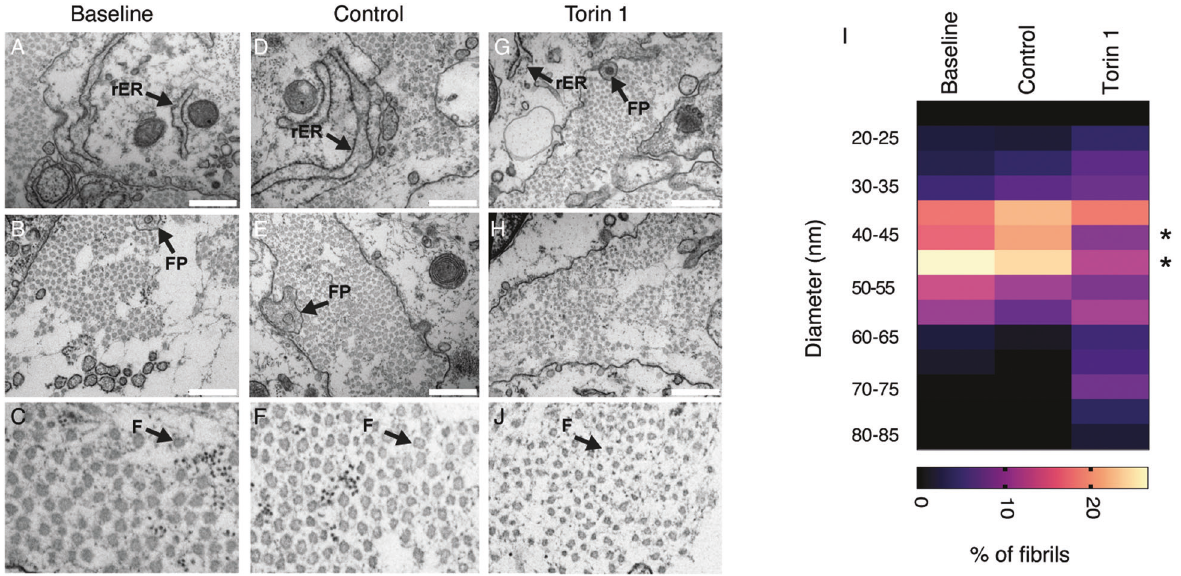
Fig. 7 Pharmacological inhibition of mTOR by Torin 1 impairs collagen fi brils morphology. A – H Representative transverse images of 3D tissue-engineered tendons analyzed by TEM. Baseline and control samples showed fi brils with similar fi bril diameter and regular shapes ( A – F ). Torin 1 samples, in contrast, showed irregular fi brils ( G, H ). rER rough endoplasmic reticulum, FP fi bripositors, F collagen fi bril. Scale bar = 500 nm. n = 3 tissue donors in each experimental group. I Heat map plot of the distribution of fi bril diameters measured in TEM images